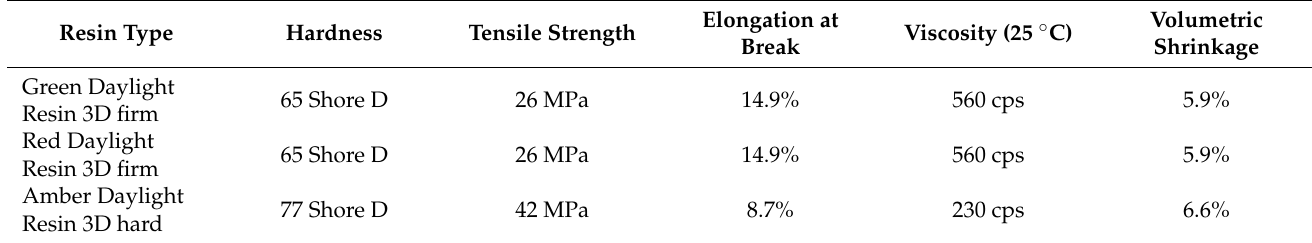
Table 1. Mechanical properties of the resins according to the manufacturer.